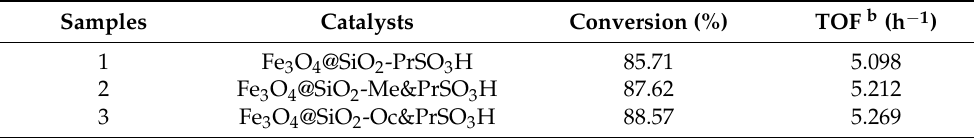
Table 3. Activity of catalysts in synthesis of EAC a .